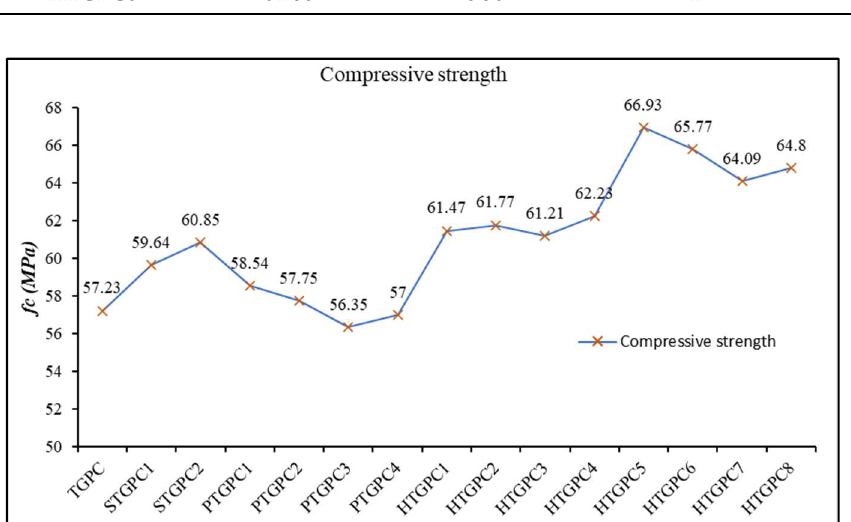
Figure 4. Comparison of compressive